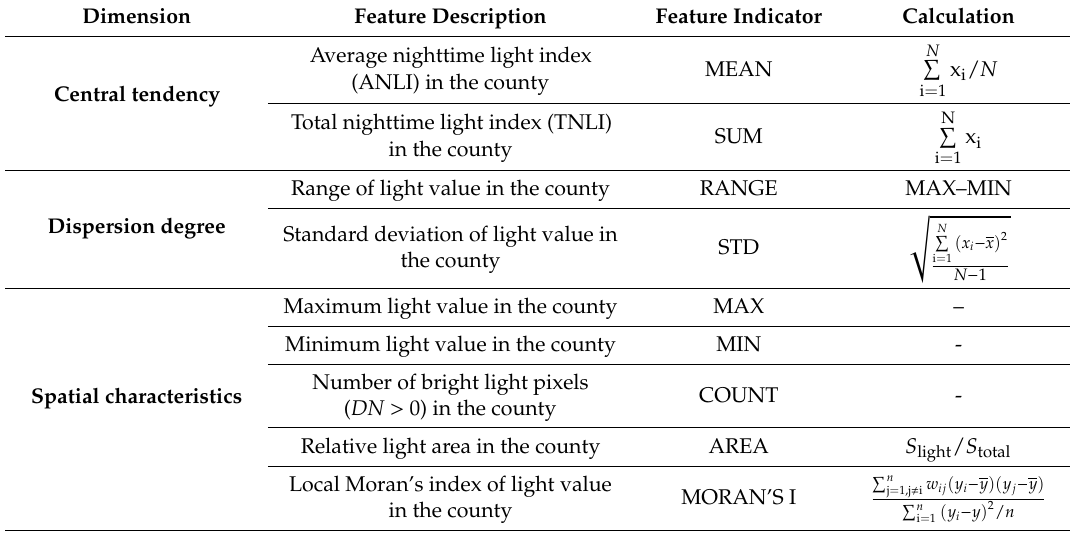
Table 4. Feature indicators of the nighttime light